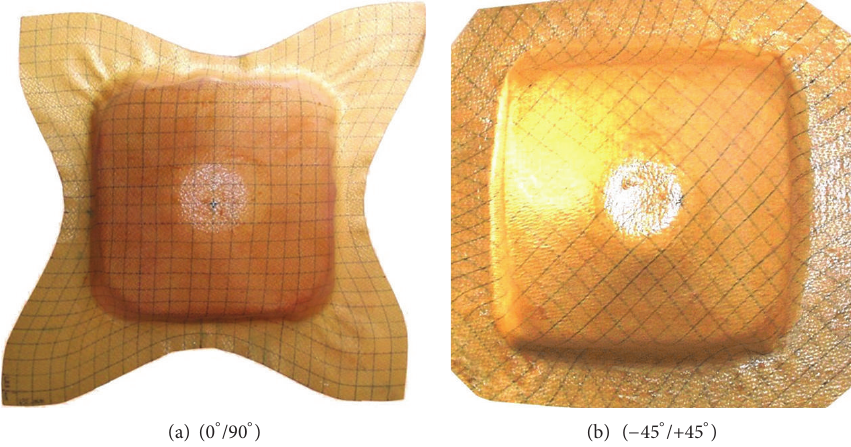
F 17: Experimental results: (a) 0